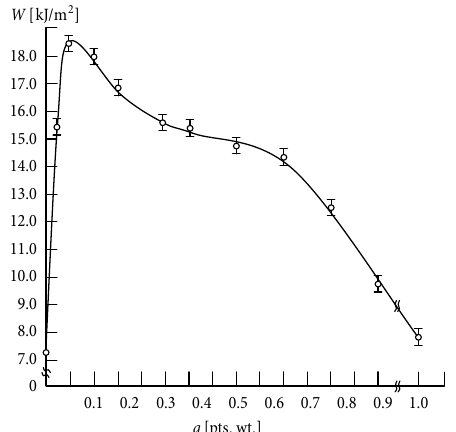
Fig. 4. Dependence of impact toughness of CM on MMSCO